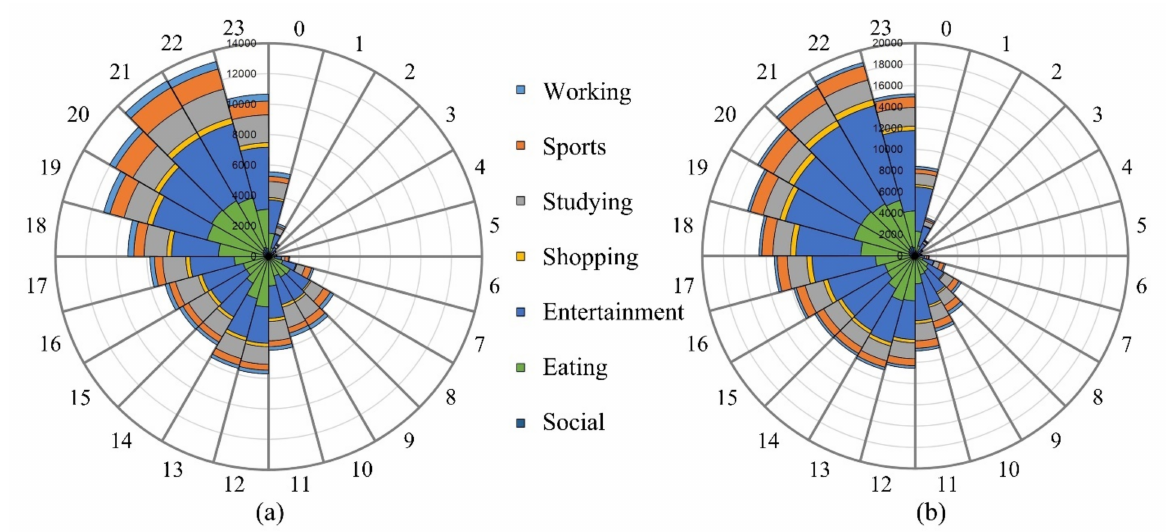
Figure 5. The hourly temporal distribution patterns of residents’ daily activities on ( a ) weekdays and ( b )